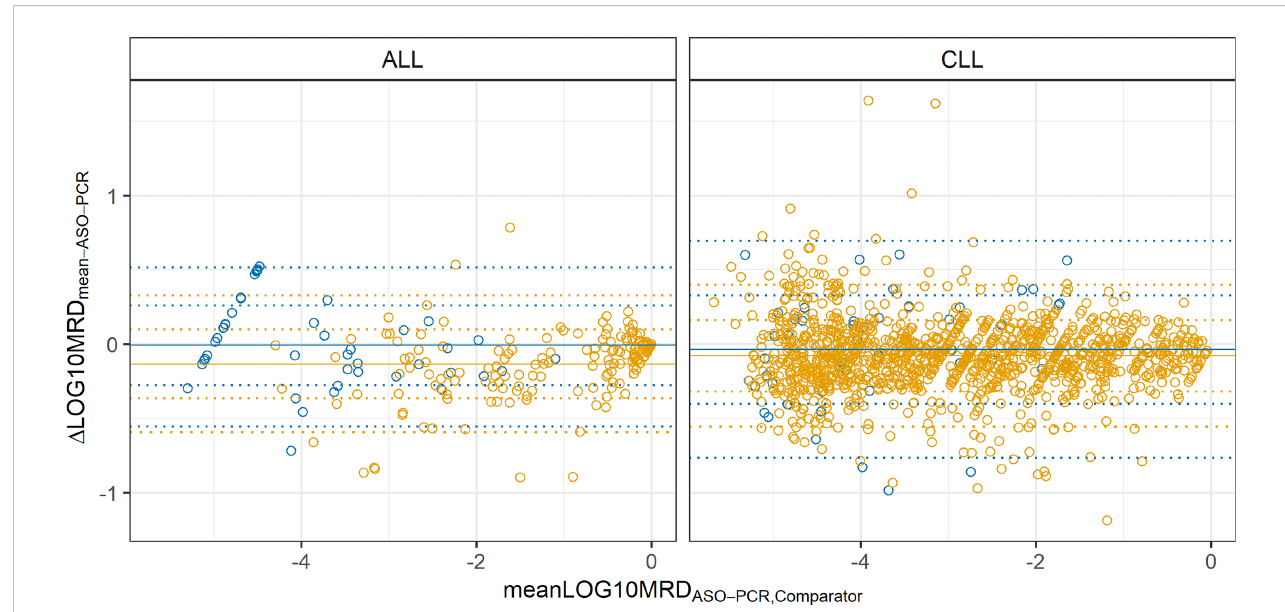
FIGURE 2 Bland-Altman plots of concordant positive MRD samples analyzed by ASO-PCR and 4-color or 8-color fl ow cytometry (yellow) and NGS (blue). 1205 CLL samples and 169 ALL samples were compared using fl ow cytometry, and 49 CLL samples and 44 ALL samples were compared using NGS. Bias (solid line) and 1S and 2S intervals (dotted lines) are